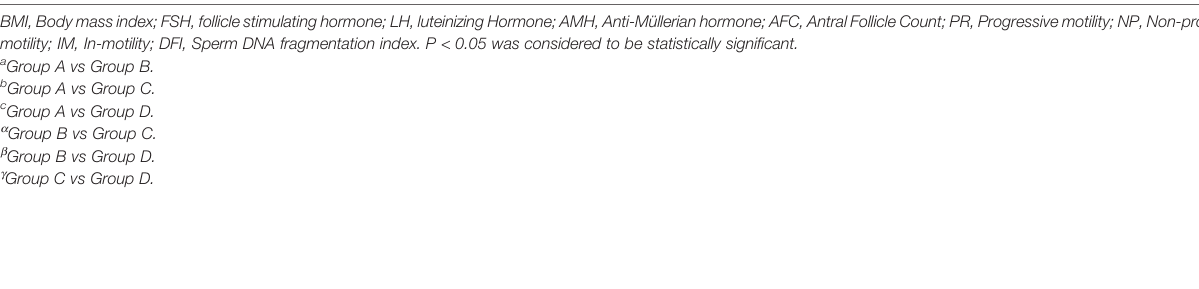
TABLE 1B | Etiological classi fi cation and methods of assisting pregnancy in different groups.